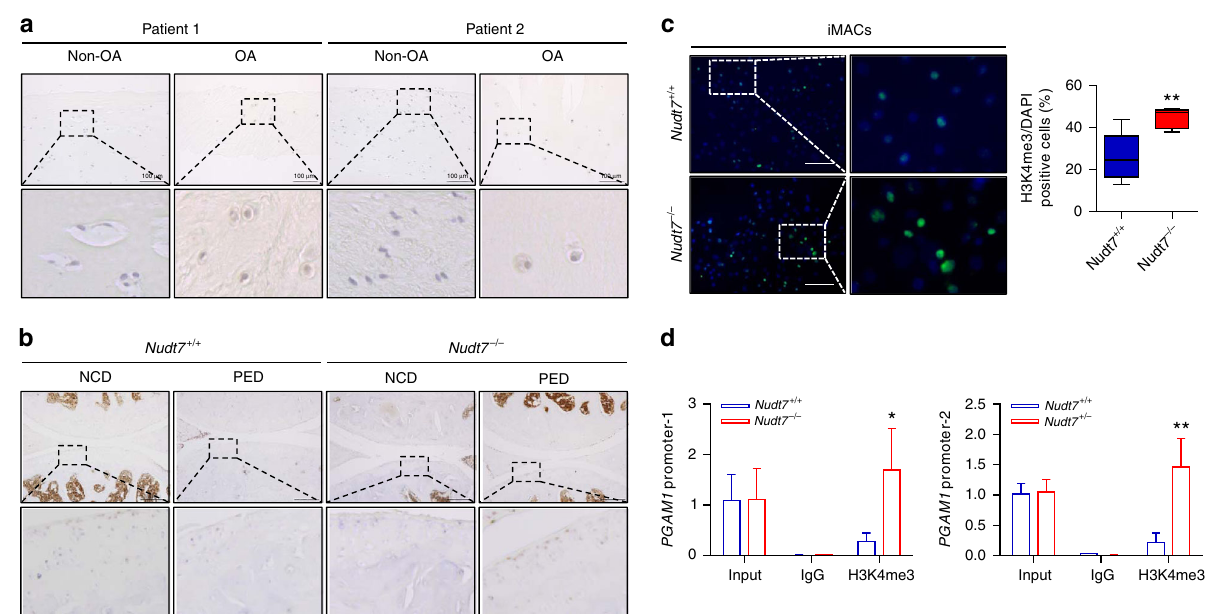
Fig. 5 Histone 3 lysine trimethylation (H3K4me3) is involved in the transcriptional activation of phosphoglycerate mutase 1 ( PGAM1 ). a , b Immunohistochemistry of H3K4me3 in human OA cartilage ( n = 5 per group; scale bars, 100 μ m) and cartilage of Nudt7 − / − mice ( n = 5 per group; scale bars, 200 μ m). c Immunocytochemistry of H3K4me3 and counting of H3K4me3-positive cells in immature murine articular chondrocytes (iMACs)